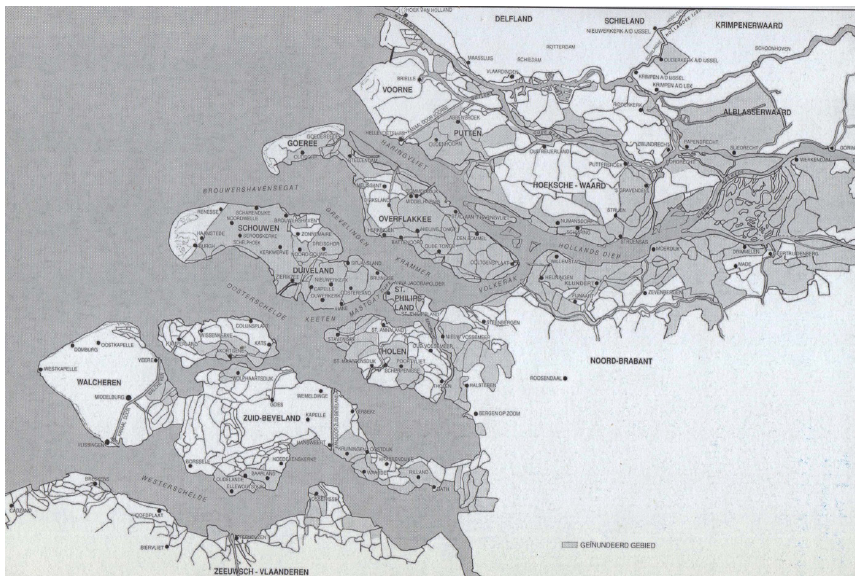
Figure 4. Reconstruction of the flooded areas (shaded) in Zeeland, parts of the provinces of South Holland and North Brabant during the storm surge of 1 February